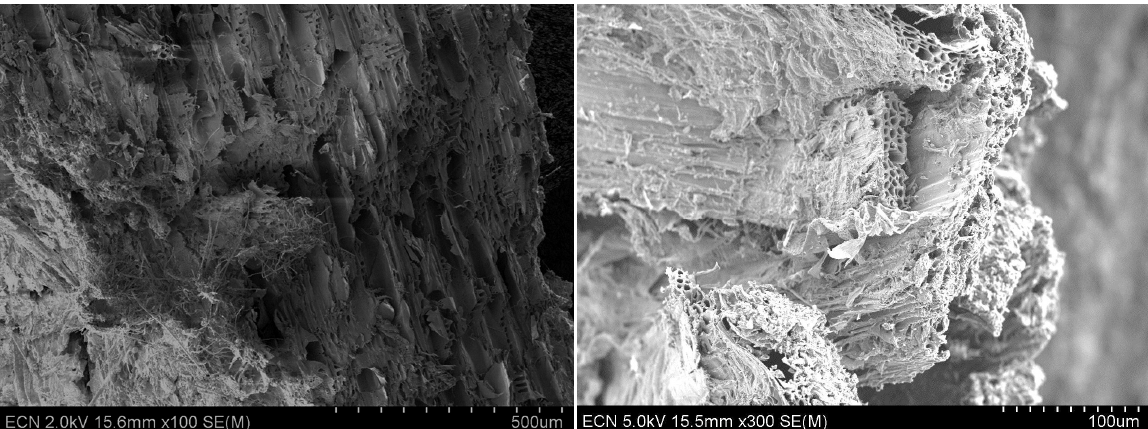
Figure 7. Comparison of the porosity in the original feedstock and the biochar.